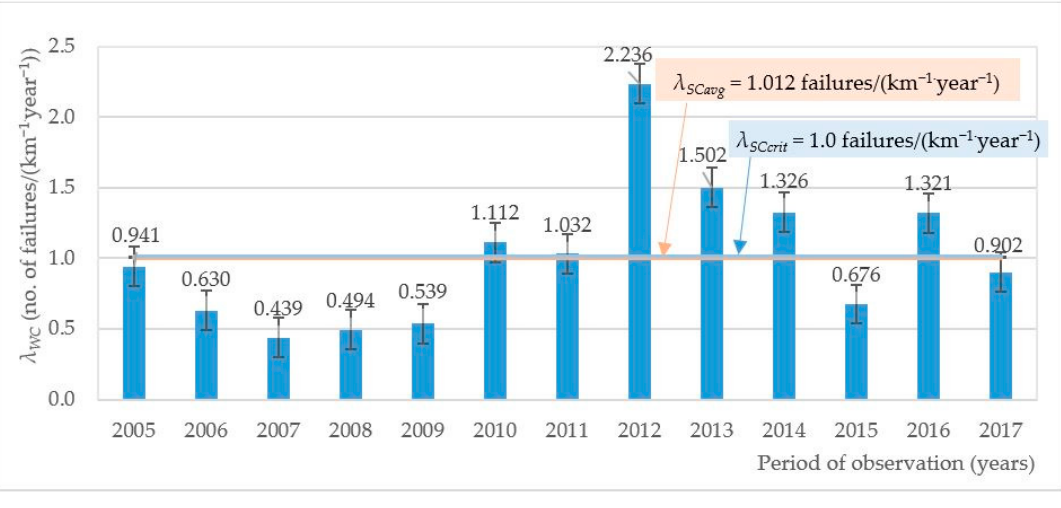
Figure 5. The failure rate for SCs over the distinguished 2005–2017 period.